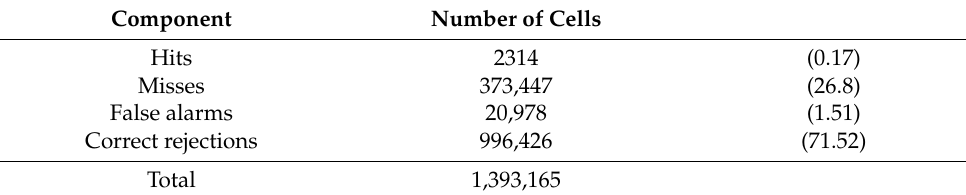
Table 3. Figure of merit components and correct rejections for the business as usual (BaU) scenario.